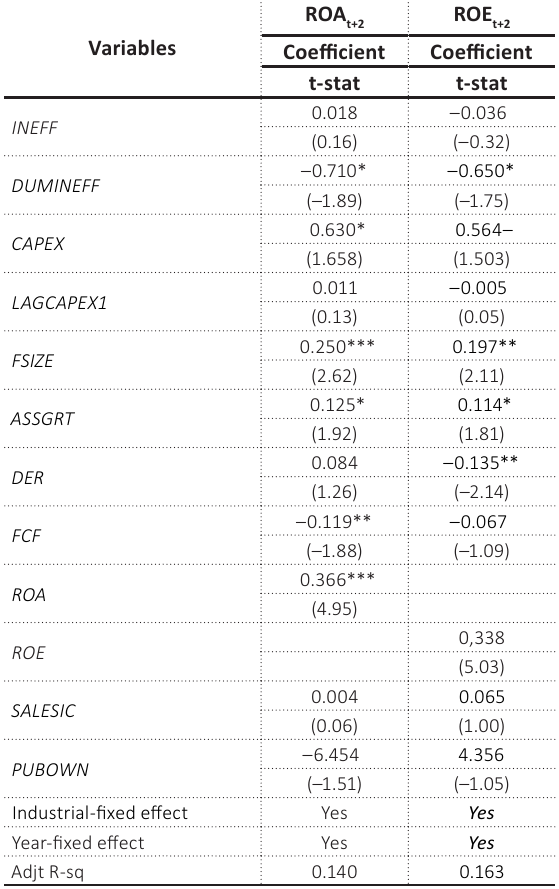
Table 7. Future financial